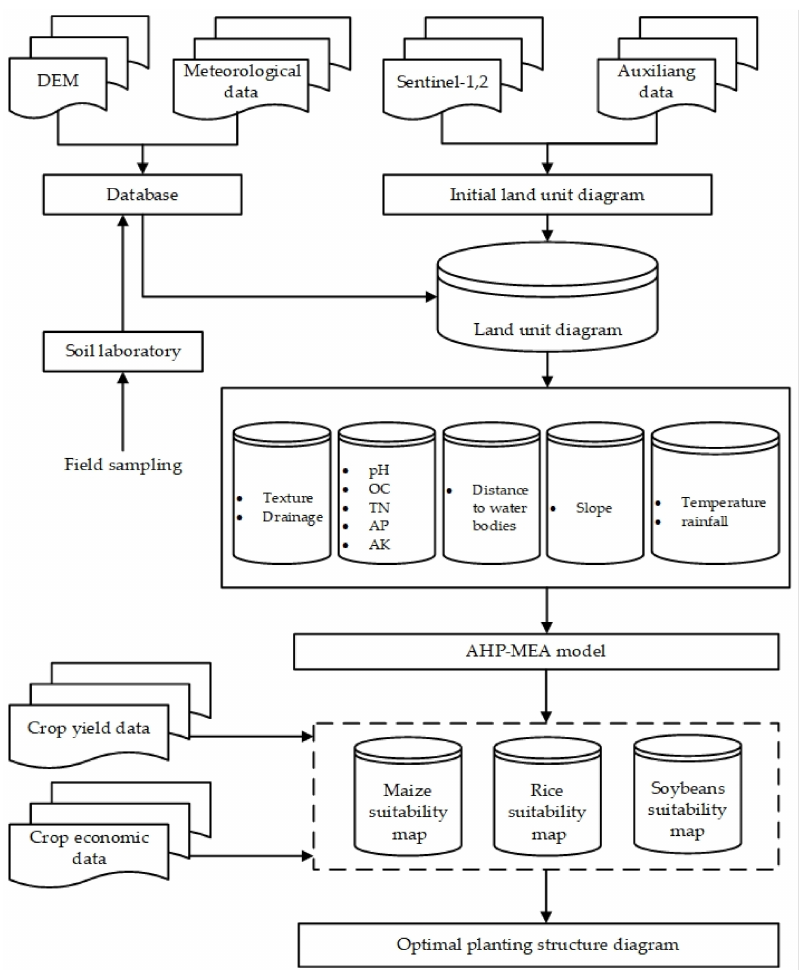
Figure 3. Schematic overview of land suitability assessment